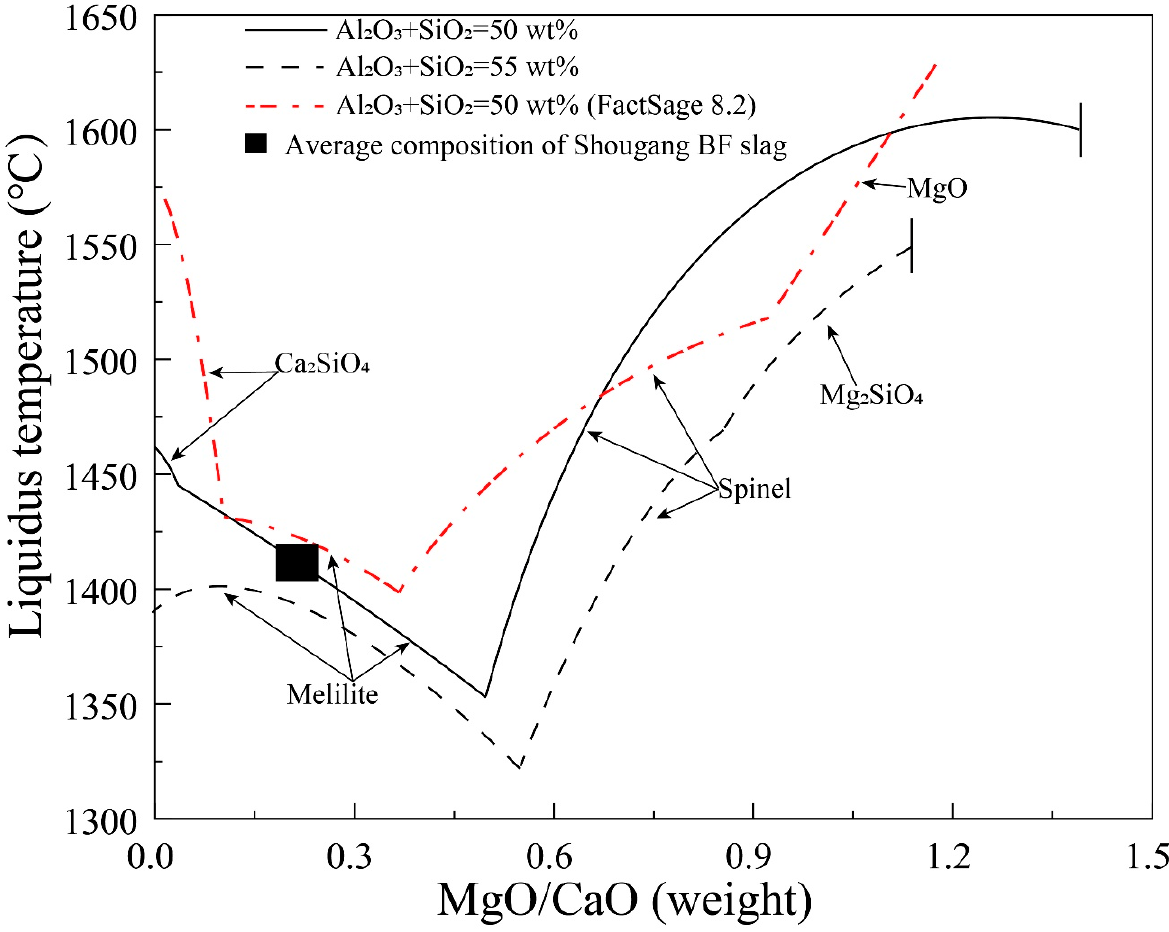
Figure 15. Liquidus temperature as a function of MgO/CaO in liquids at fixed (Al 2 O 3 + SiO 2 ) of 50 and 55 wt% in the CaO-MgO-SiO 2 -Al 2 O 3 system with Al 2 O 3 /SiO 2 weight ratio of 0.4 [22]. The raw materials for a BF are not always fixed, in particular for the small BFs. It is im- the BF slags. Figure 16 indicates a pseudo-ternary phase diagram (CaO + MgO)-SiO 2 -Al 2 O 3 system at a constant MgO/CaO = 0.2. The end members are Al 2 O 3 , SiO 2 and (CaO + MgO) slags to be discussed